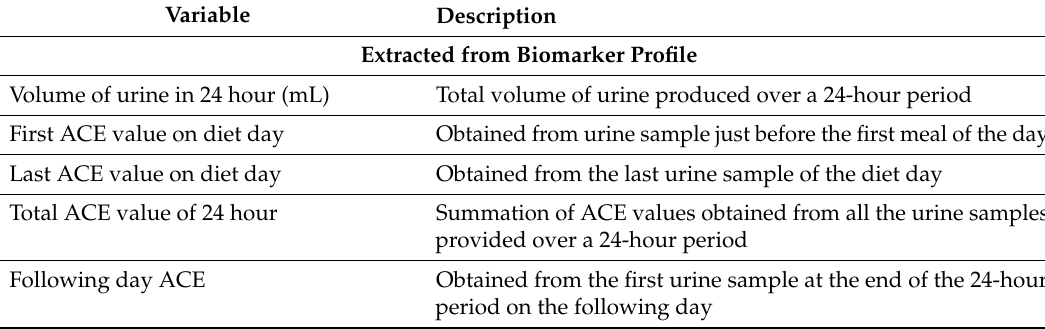
Table 1. Variables found. Variables extracted from ACE profile obtained from the urine samples